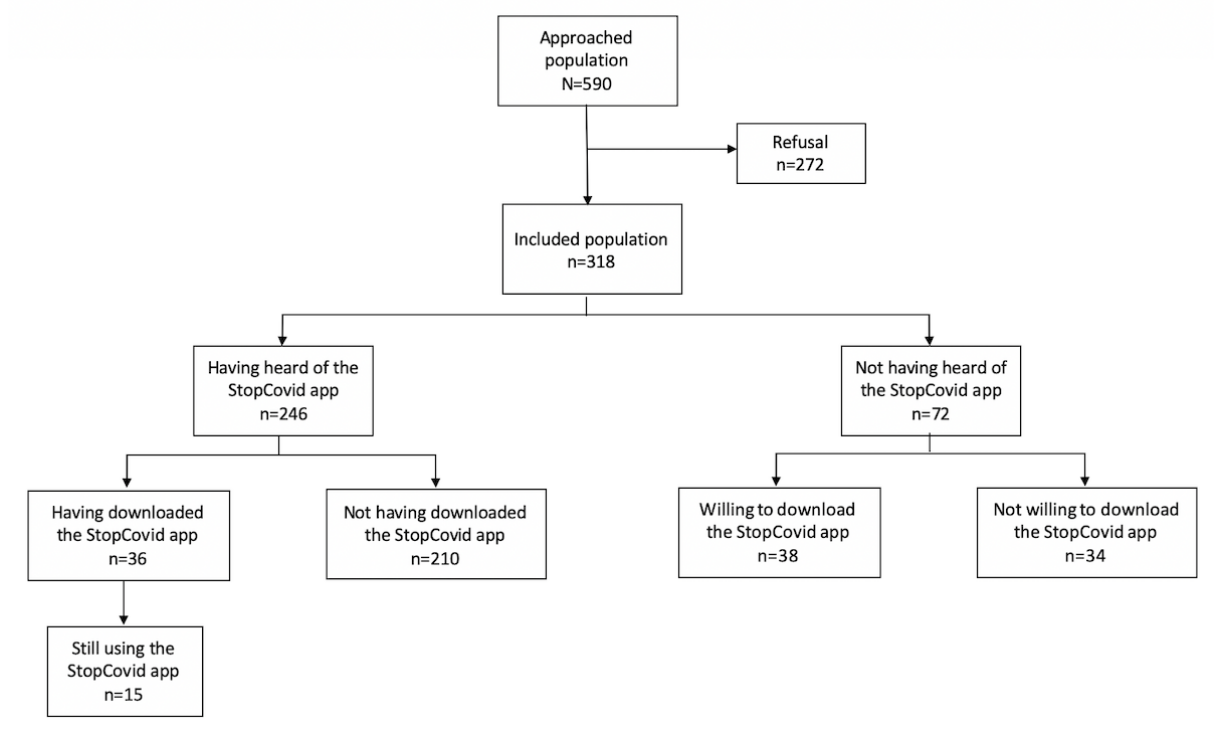
Figure 1. Flowchart of the study population